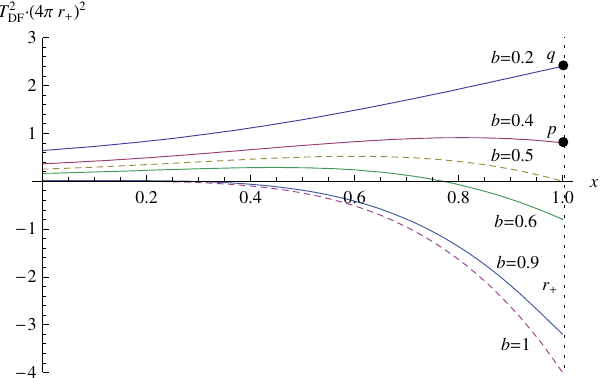
· ( 4 π r 2 ) 2 along x = r + / r for + DF